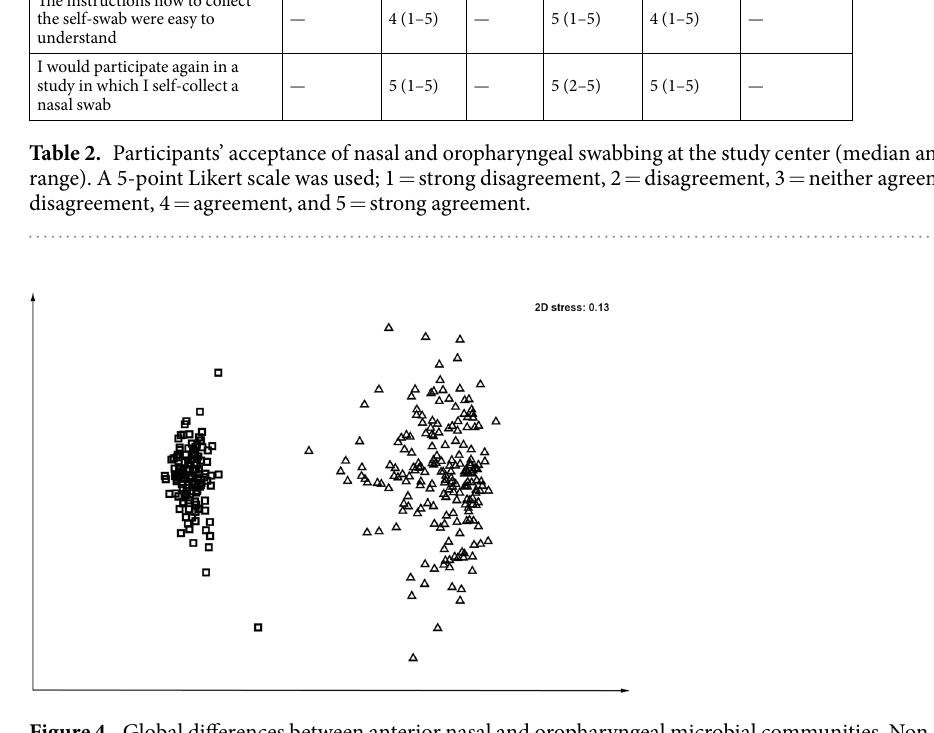
these two habitats differed drastically, forming two separate clusters in the non-metric multidimensional scaling (nMDS) plot (Fig. 4). The oropharyngeal communities tended to cluster more tightly together than the nasal communities; in agreement with, multivariate dispersion analysis showed that the index of dispersion was higher for anterior nasal communities (1.09) than for oropharyngeal communities (0.73). This is in accordance with the higher average similarity between all pairs of oropharyngeal communities of 34.8%, compared to only 26.5% between all pairs of anterior nasal communities. The anterior nasal communities were dominated by Actinobacteria (mean abundance of 45% in a total of 195 samples analyzed), Firmicutes (40%) and Proteobacteria (12%), along with minor amounts of Bacteroidetes (2%).